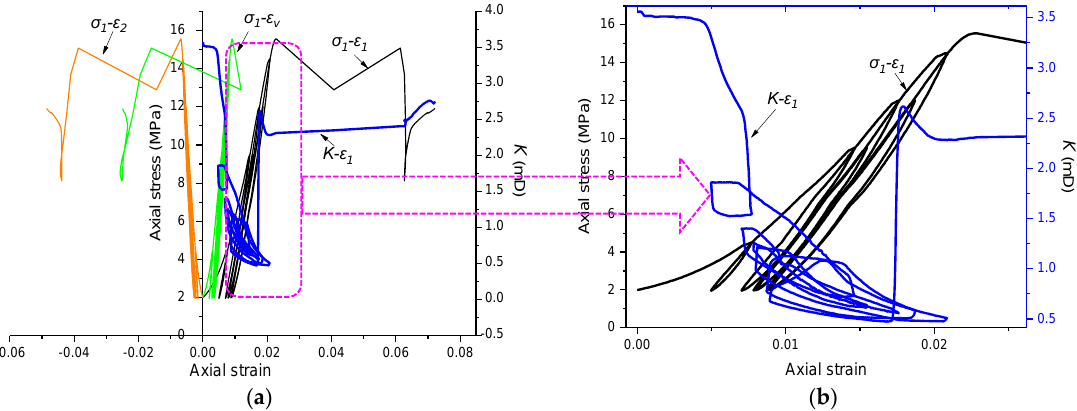
Figure 10. The relationships among stress, strain, and permeability of raw coal under stress path 3. ( a ) Stress–strain and permeability–strain curves. ( b ) Partial enlargement. ( a ) Stress–strain and permeability–strain curves. ( b ) Partial